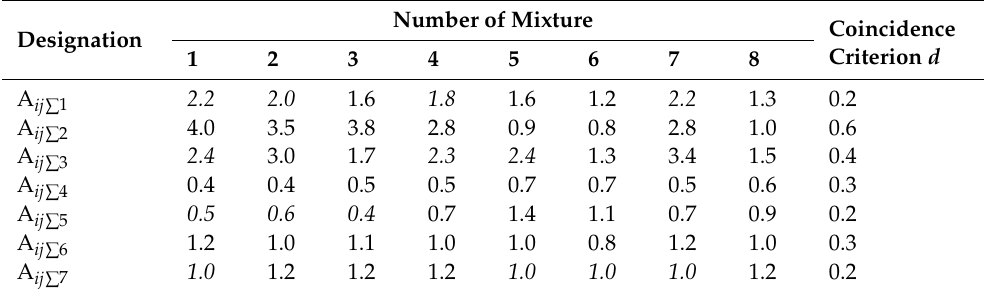
Table 12. Parameters A ij ∑ for model mixtures, calculated considering the kinetic features of sorption on sensors with polycomposite coatings ( n = 3, Sr (0.05) < 0.15).